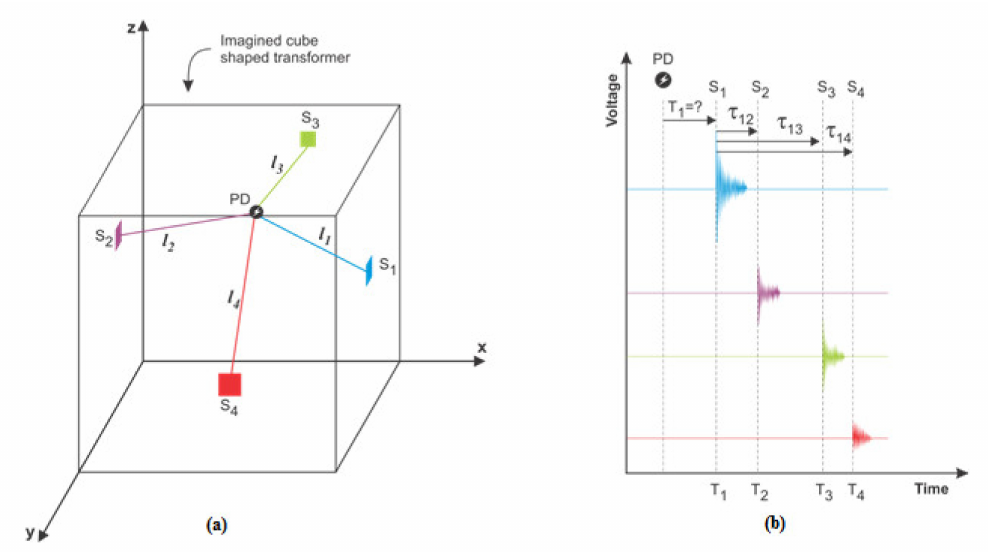
Figure 1. System for detecting the location of partial discharge (PD) by the non-iterative all-acoustic method; ( a ) spatial arrangement of sensors and PD in an imagined cube-shaped transformer; ( b ) appearance of acoustic signals of PD recorded by four acoustic sensors S 1 , S 2 , S 3 , and S 4